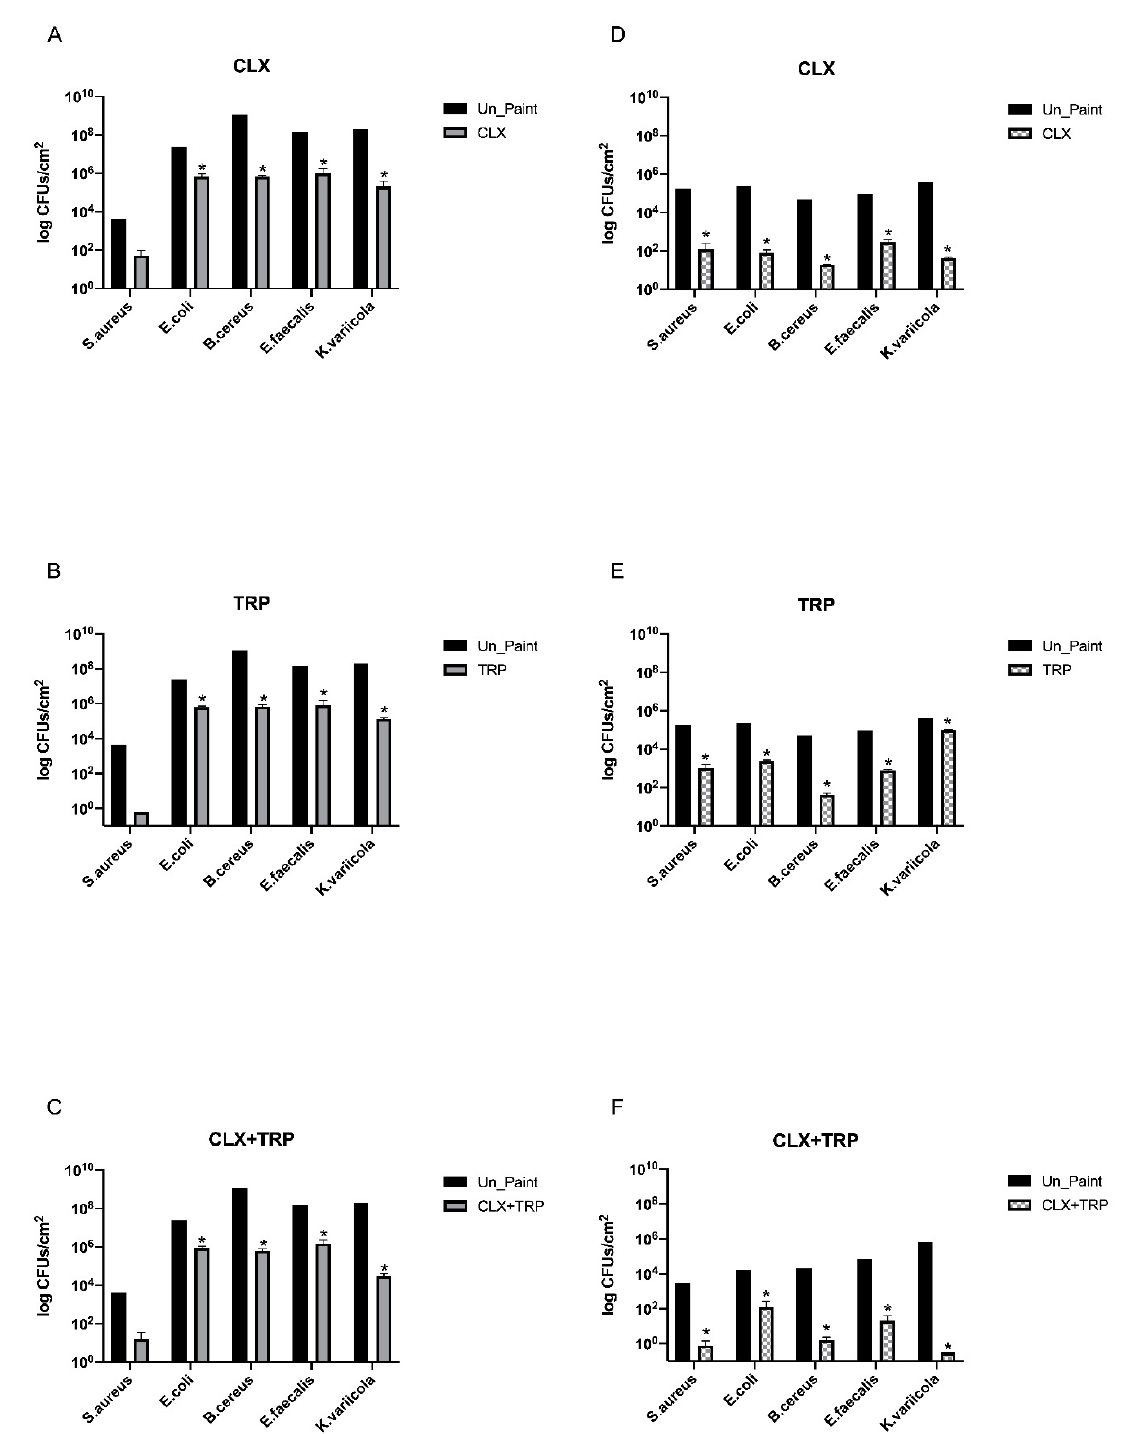
Figure 3. Average number of viable CFUs/cm 2 recovered from each antimicrobial paint before ( A – C ) (left) and after ( D – F ) (right) scrub resistance test followed by 24 h of incubation. The values are presented in logarithmic scale. The values are expressed as mean ± standard deviation. The statistical significance of samples (CLX/TRP/CLX+TRP) compared with Un_Paint is represented by *. (Two-way ANOVA; p < 0.05).